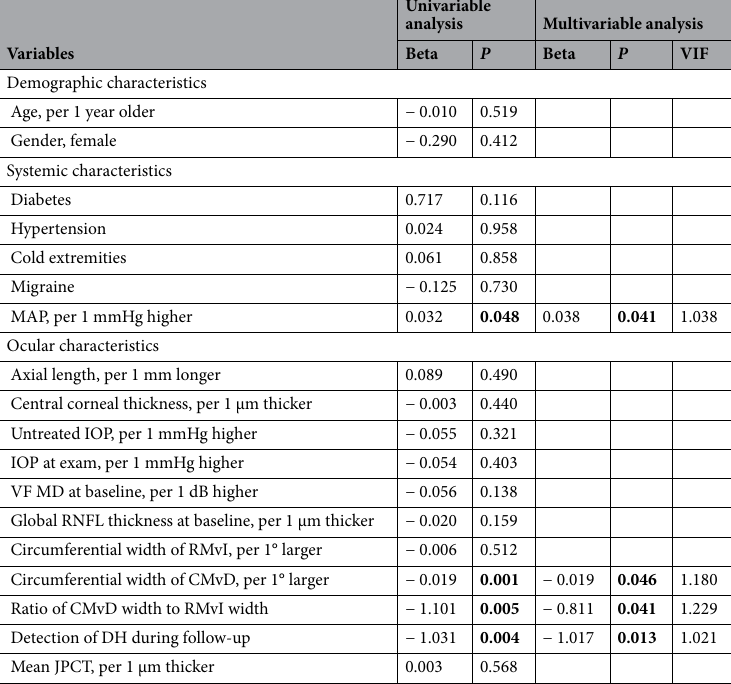
Table 4. Factors associated with rate of global retinal nerve fiber layer thinning in all POAG eyes (n = 88). Variables with P < 0.1 in the univariable analysis were included in the multivariable model. Values with statistical significance are shown in boldface. VIF variance inflation factor, MAP mean arterial pressure, IOP intraocular pressure, VF visual field, MD mean deviation, RNFL retinal nerve fiber layer, RMvI retinal microvascular impairment, CMvD choroidal microvasculature dropout, DH disc hemorrhage, JPCT juxtapapillary choroidal